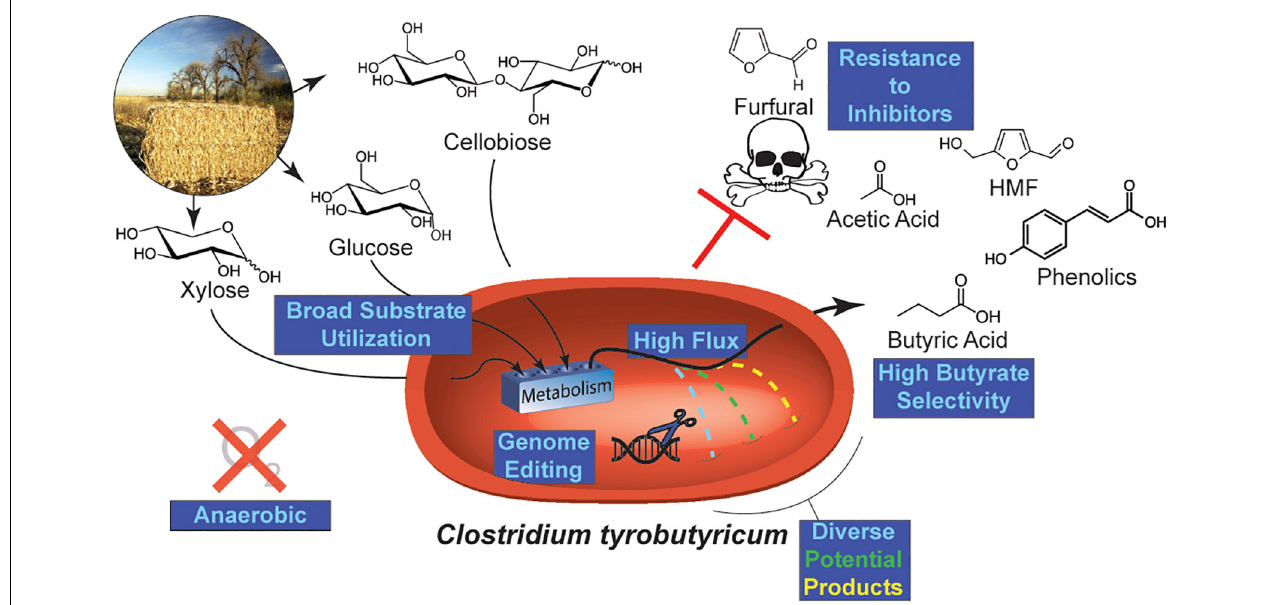
FIGURE 1 | Beneficial traits inherent and developed for Clostridium tyrobutyricum which make it an exemplary biocatalyst for the production of suites of fuel and chemical precursors from lignocellulosic